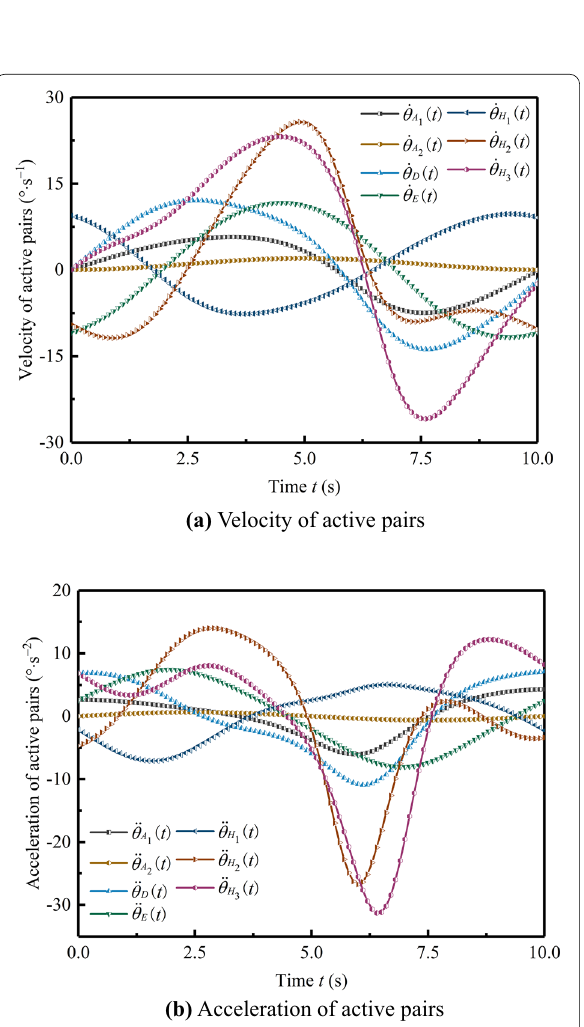
Figure 11 First method of inverse kinematics analysis